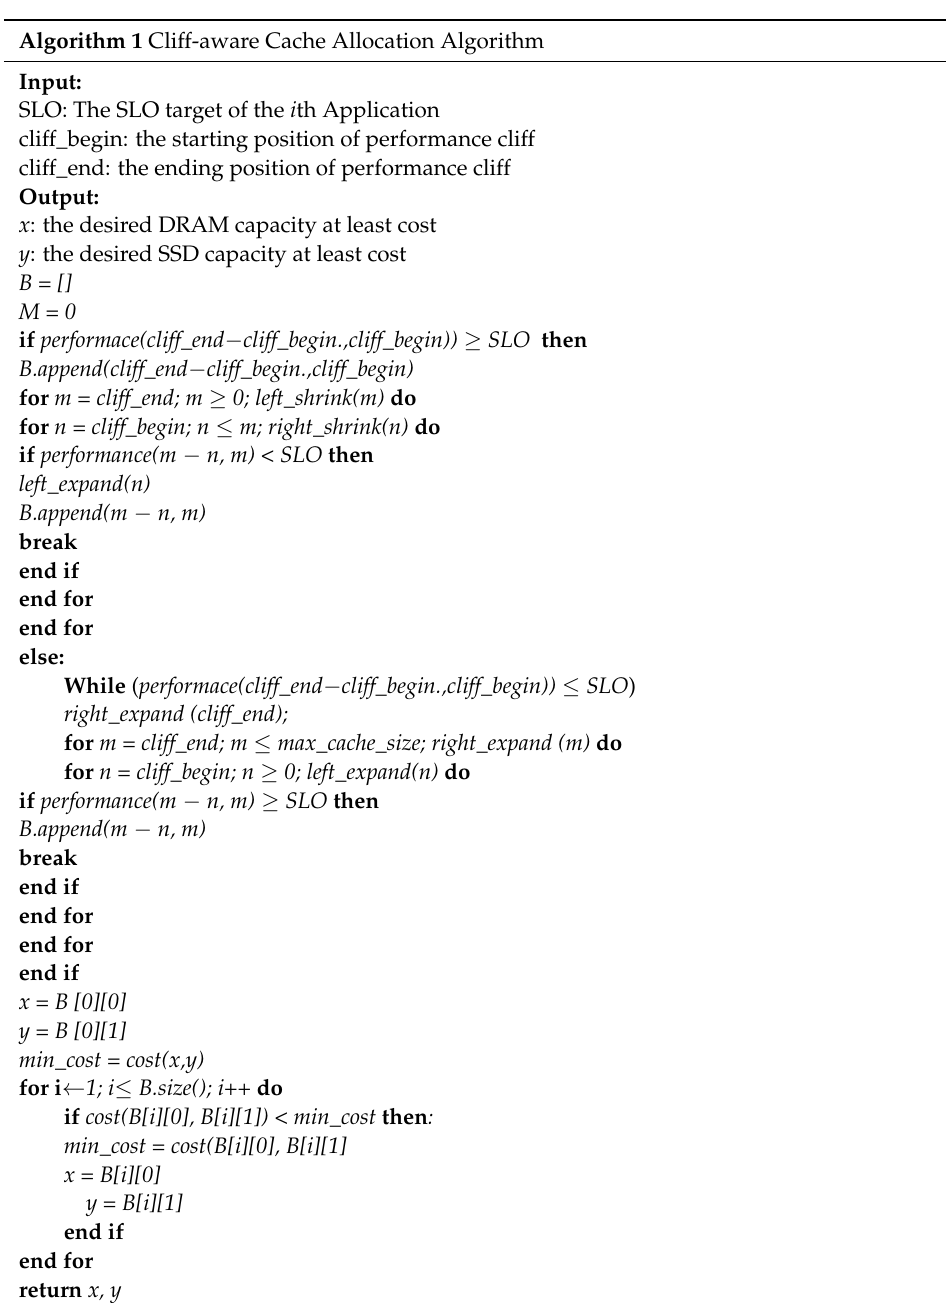
Algorithm 1 Cliff-aware Cache Allocation